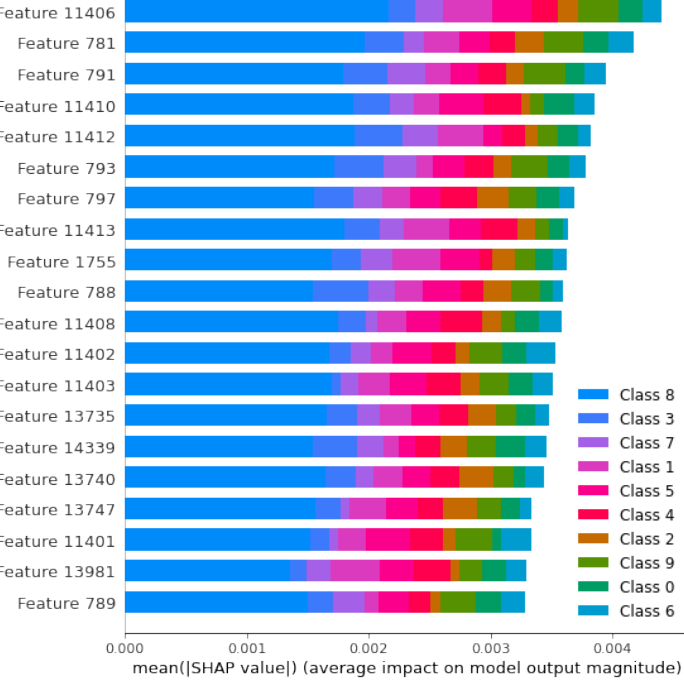
Figure A1. Example of top 20 features with the most influence on classification estimated by SHAP. Here, Class N corresponds to the intensity I = 0.1 × ( N + 1 ) . Feature F corresponds to the time F /250 s from the beginning of image